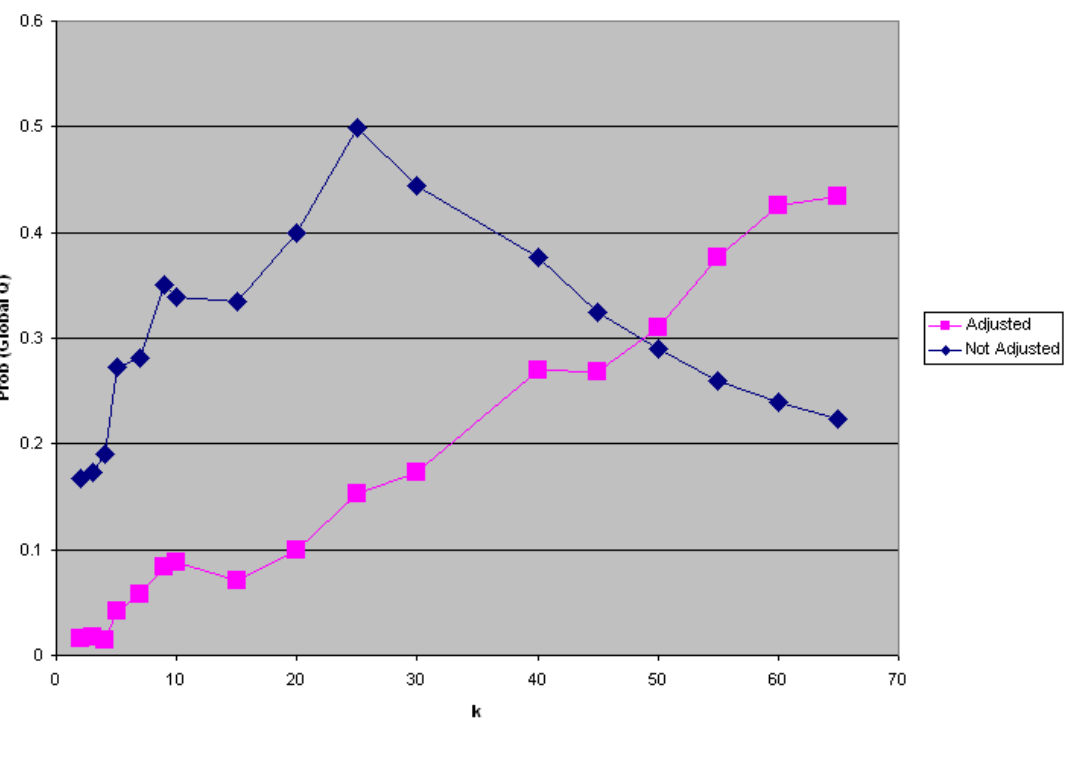
Figure 5. The sensitivity analysis using the Global (cid:1843) - statistic found significant global clustering of cases relative to controls after statistical adjustment for covariates and risk factors at k = 2, 3, and 4, with p < 0.01 at k = 4 nearest neighbors. This analysis was conducted at the spatial scale of Marin